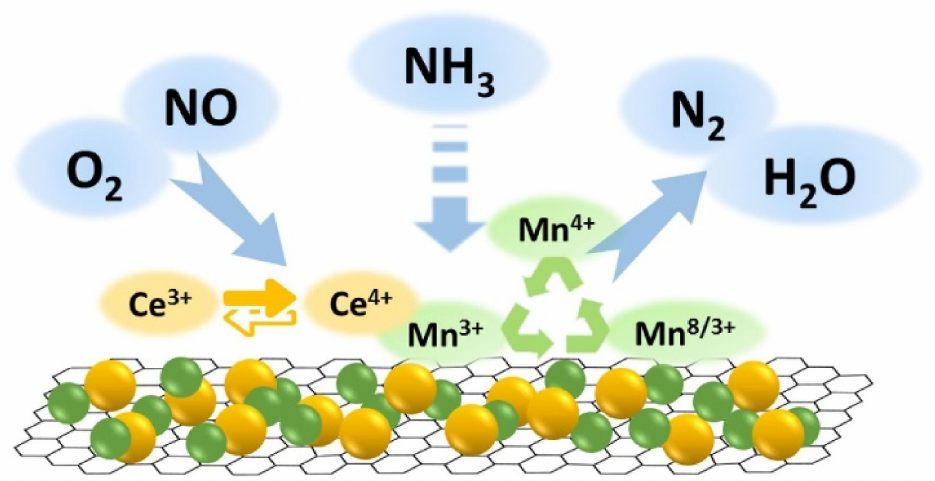
Figure 5. The schematic diagram of the catalytic mechanism of MnO x -CeO 2 /RGA Reproduced with permission from Reference [75]; copyright (2019),